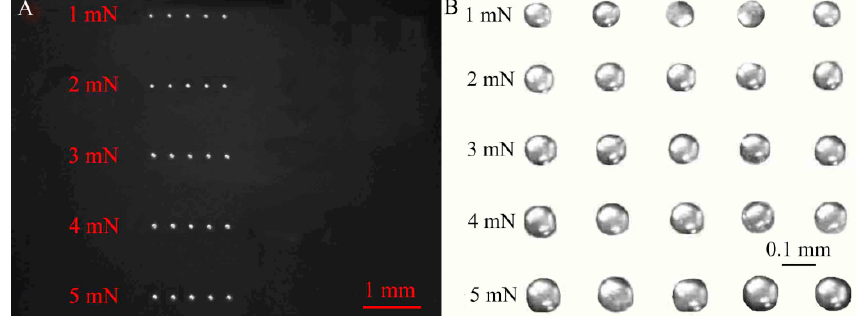
Figure 5. Adhesive droplets array before ( A ) and after ( B ) magnification under 1–5 mN.